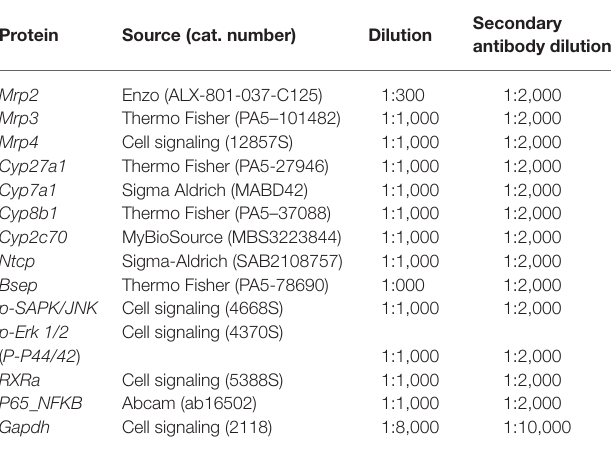
TABLE 2 | Primary and secondary antibodies used in Western